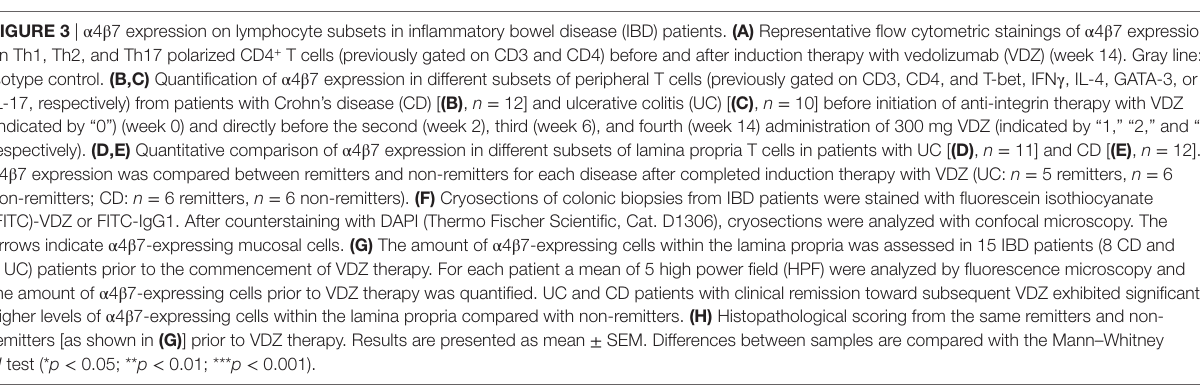
FigUre 3 | α 4 β 7 expression on lymphocyte subsets in inflammatory bowel disease (IBD) patients. (a) Representative flow cytometric stainings of α 4 β 7 expression on Th1, Th2, and Th17 polarized CD4 + T cells (previously gated on CD3 and CD4) before and after induction therapy with vedolizumab (VDZ) (week 14). Gray line: isotype control. (B,c) Quantification of α 4 β 7 expression in different subsets of peripheral T cells (previously gated on CD3, CD4, and T-bet, IFN γ , IL-4, GATA-3, or IL-17, respectively) from patients with Crohn’s disease (CD) [ (B) , n = 12] and ulcerative colitis (UC) [ (c) , n = 10] before initiation of anti-integrin therapy with VDZ (indicated by “0”) (week 0) and directly before the second (week 2), third (week 6), and fourth (week 14) administration of 300 mg VDZ (indicated by “1,” “2,” and “3,” respectively). (D,e) Quantitative comparison of α 4 β 7 expression in different subsets of lamina propria T cells in patients with UC [ (D) , n = 11] and CD [ (e) , n = 12]. α 4 β 7 expression was compared between remitters and non-remitters for each disease after completed induction therapy with VDZ (UC: n = 5 remitters, n = 6 non-remitters; CD: n = 6 remitters, n = 6 non-remitters). (F) Cryosections of colonic biopsies from IBD patients were stained with fluorescein isothiocyanate (FITC)-VDZ or FITC-IgG1. After counterstaining with DAPI (Thermo Fischer Scientific, Cat. D1306), cryosections were analyzed with confocal microscopy. The arrows indicate α 4 β 7-expressing mucosal cells. (g) The amount of α 4 β 7-expressing cells within the lamina propria was assessed in 15 IBD patients (8 CD and 7 UC) patients prior to the commencement of VDZ therapy. For each patient a mean of 5 high power field (HPF) were analyzed by fluorescence microscopy and the amount of α 4 β 7-expressing cells prior to VDZ therapy was quantified. UC and CD patients with clinical remission toward subsequent VDZ exhibited significantly higher levels of α 4 β 7-expressing cells within the lamina propria compared with non-remitters. (h) Histopathological scoring from the same remitters and non- remitters [as shown in (g) ] prior to VDZ therapy. Results are presented as mean ± SEM. Differences between samples are compared with the